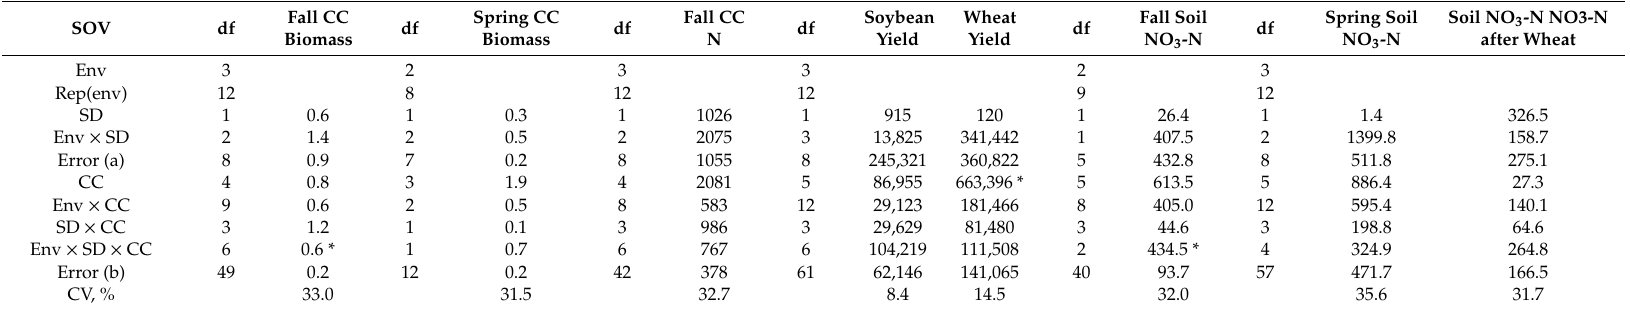
Table 3. Analysis of variance and mean squares for five cover crops (CC) and two sowing dates (SD) for fall cover crop biomass, spring cover crop biomass, fall cover crop N accumulation, soybean yield, spring-wheat yield, fall soil NO 3 -N, spring soil NO 3 -N, and soil NO 3 -N after spring wheat across four environments (Env) at Fargo and Prosper, ND, in 2016 to 2018.